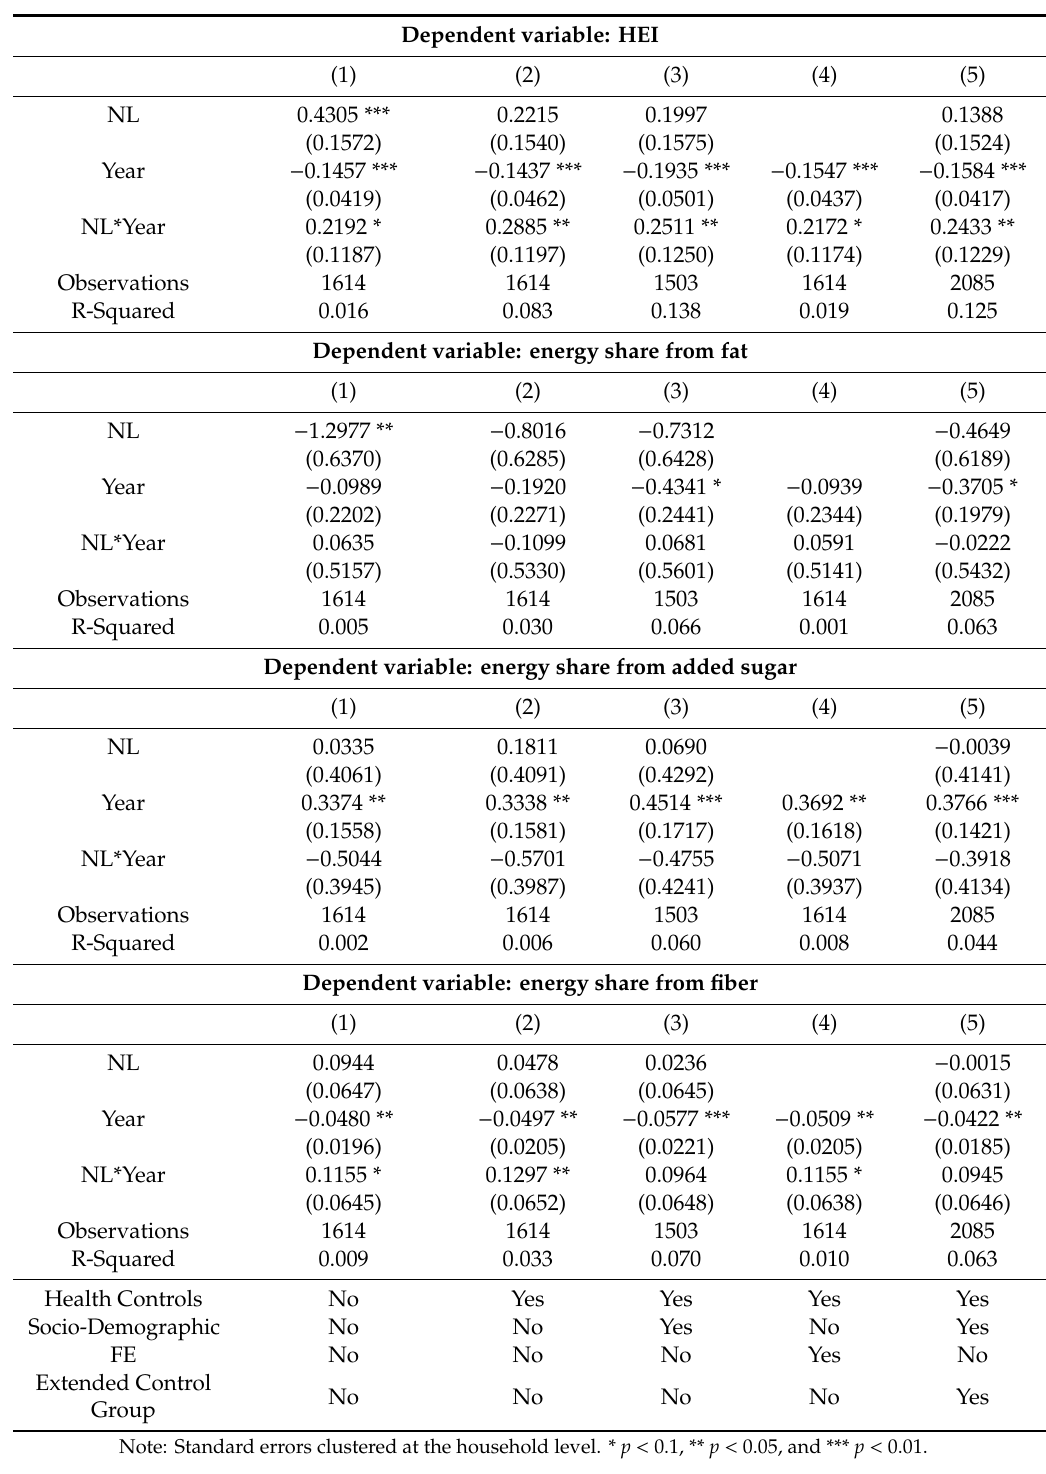
Table 5. Di ff erence-in-di ff erence for